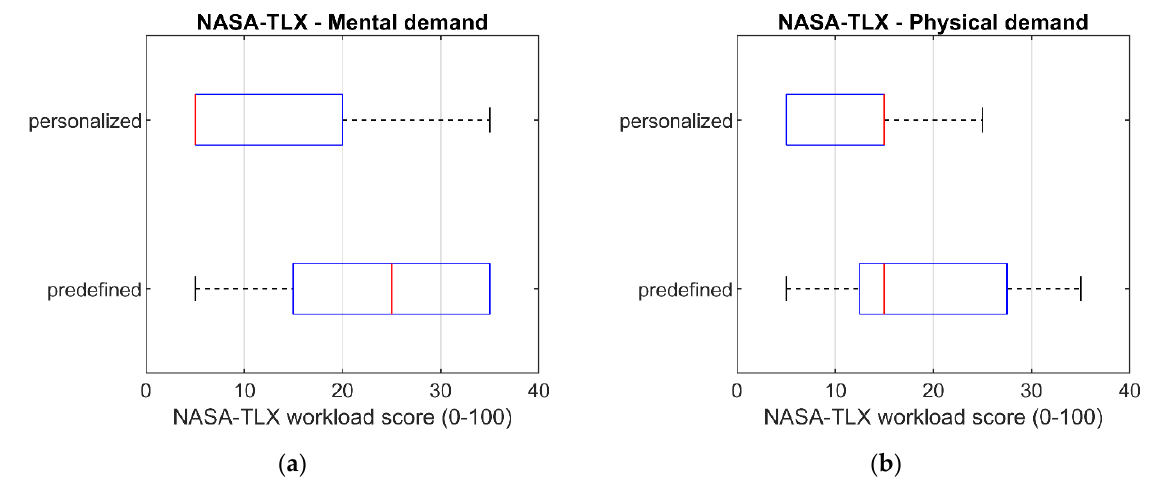
Figure 14. Boxplots representing the average score in the ( a ) mental and ( b ) physical workload. The personalized interaction displayed a statistically significant lower mental and physical workload when compared with the predefined gestures.